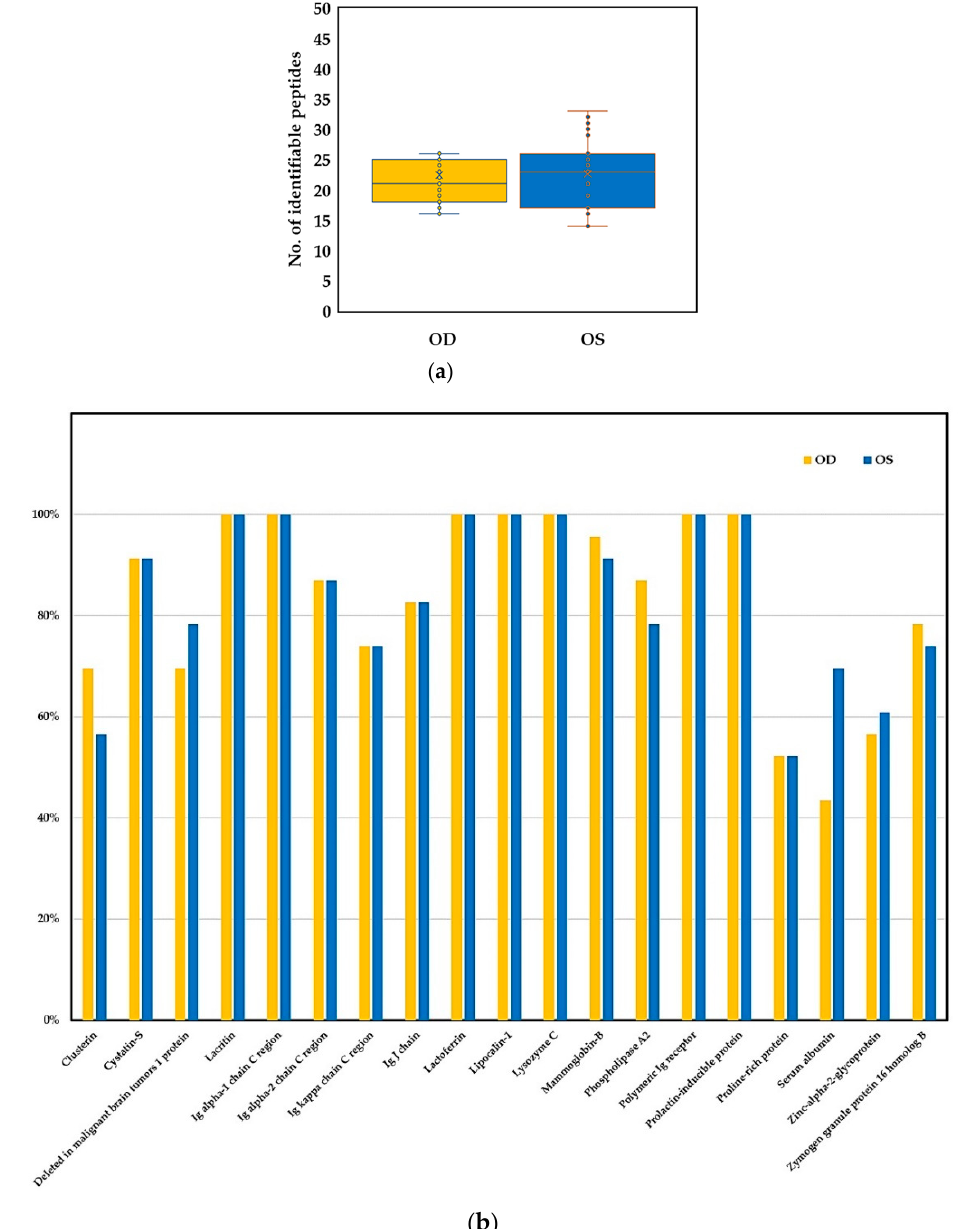
Figure 2. Tear proteome analyzed by the liquid chromatograph coupled tandem mass spectrometry in binocular tear sam- ples of dry eye patients ( N = 23). ( a ) comparison in the number of identified peptides ( p = 0.6153); ( b ) comparison in the isolation rate of common identified peptides. Abbreviation: Ig, immunoglobulin.